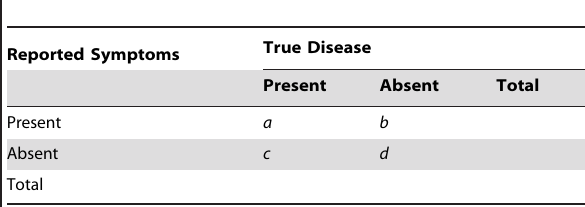
Table 1. Distribution of cases of ‘‘true pneumonia’’ (true disease) according to caregiver report of ‘‘suspected pneumonia’’ (reported symptoms) and true disease